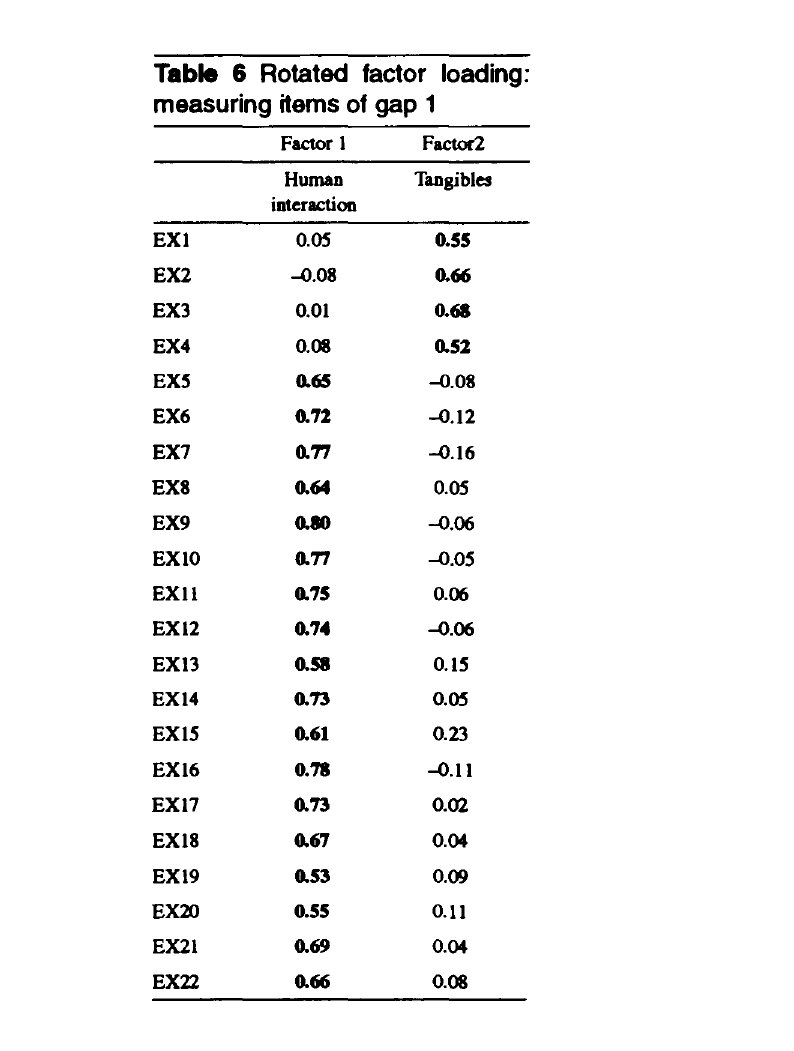
Table 6 Rotated factor loading: